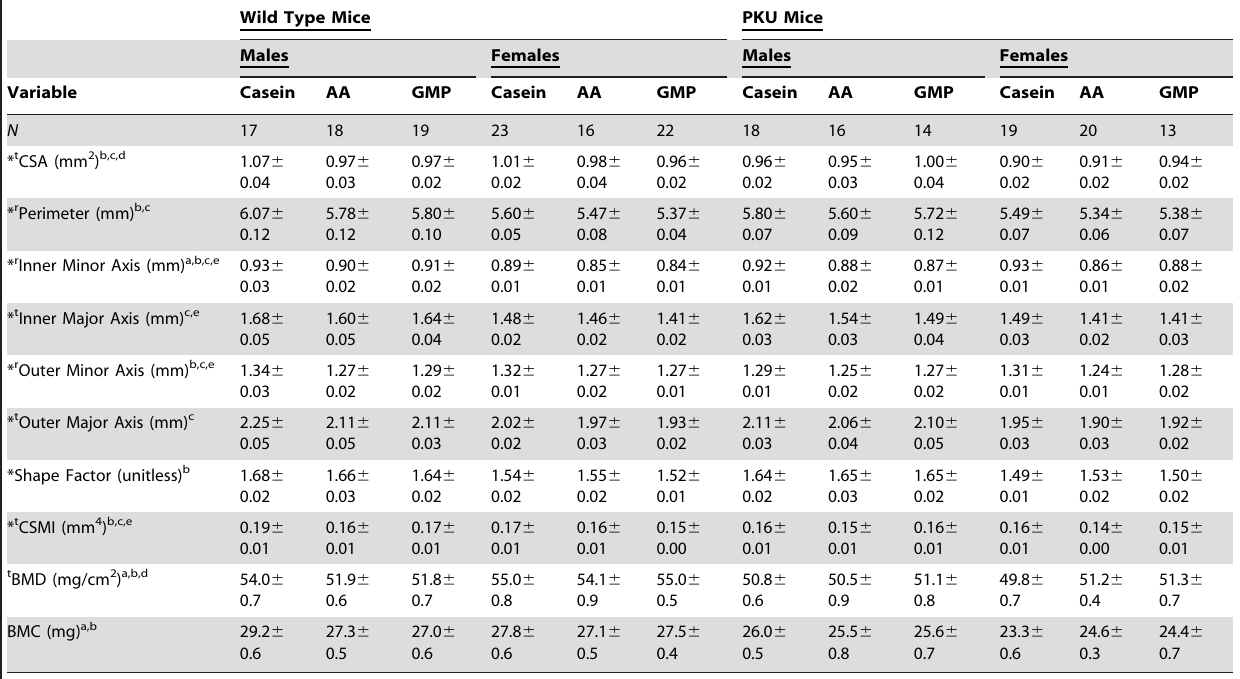
Table 3. Size, shape, and content of mice femora.